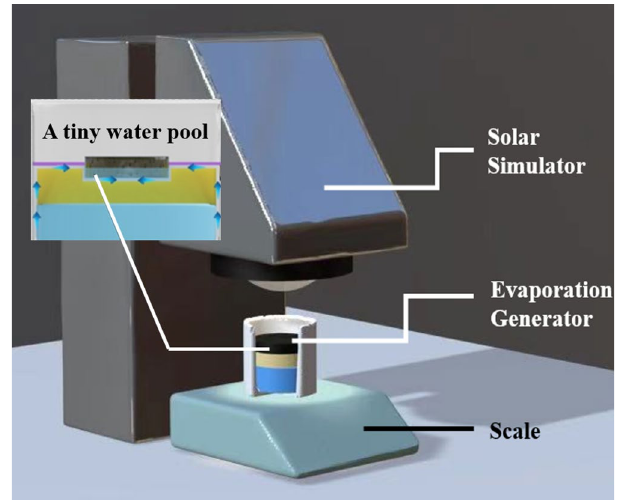
Figure 5. Schematic of solar simulation and solar-driven water desalination